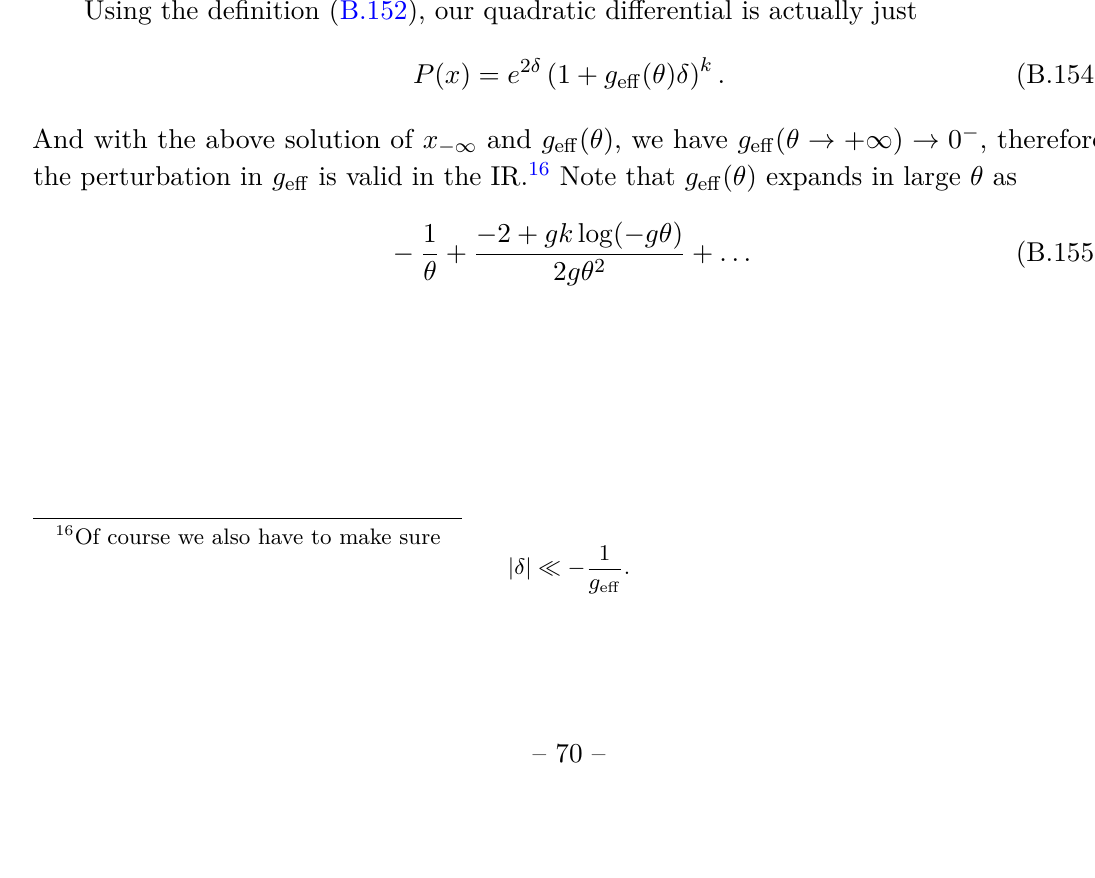
( θ ) that is complex. So it −∞ discussed eff